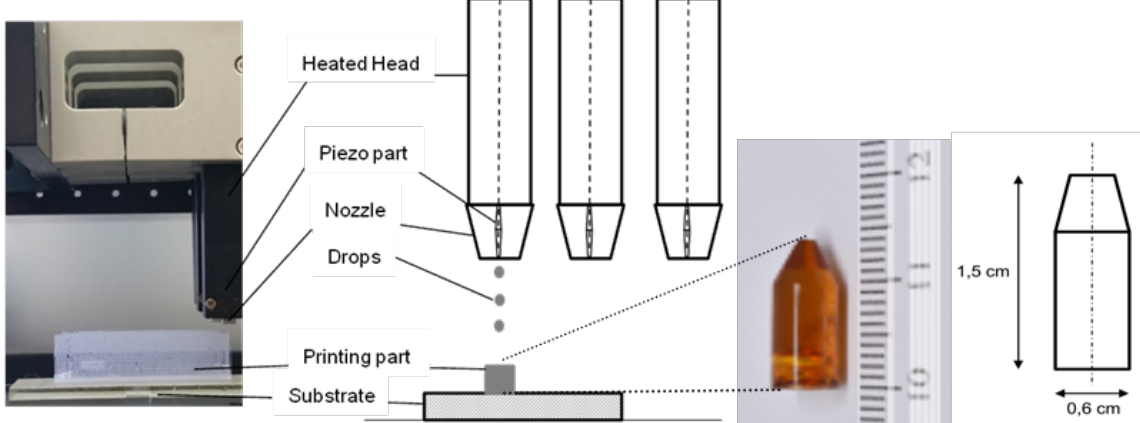
Figure 1: Prototype of 3D-printer and specimen of a 3D-printed test